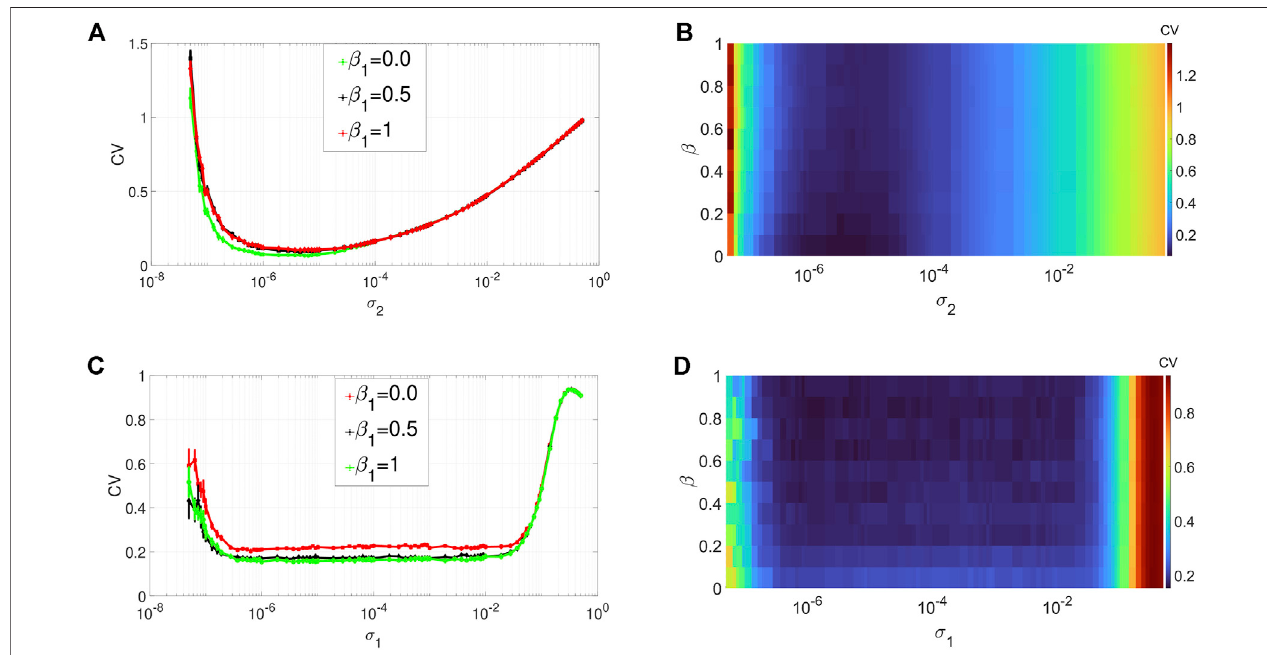
FIGURE3| VariationofCVw.r.t.thewiringprobability β 1 andthenoiseintensity σ 1 forSISRor σ 2 forCR.Panels (A) and (b) show the CV curves due to CR ( σ 1 = 0, ε 〈 s 〉 = 2). Panels (C) and (D) show the CV curves due to SISR ( σ 1 = 0.01, 1